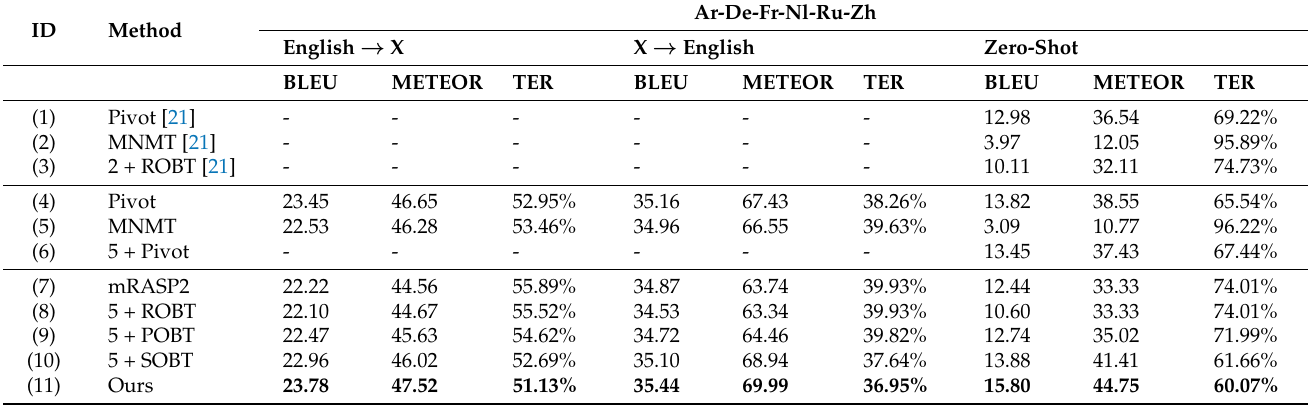
Table 4. Performance on the OPUS-100 dataset. The dataset only present 15 zero-shot directions for Arabic, Chinese, Dutch, French, German, and Russian, as applying bilingual NMT to each language pair is resource-consuming. The best results, indicated in bold, are statistically significant against all other results, for p <